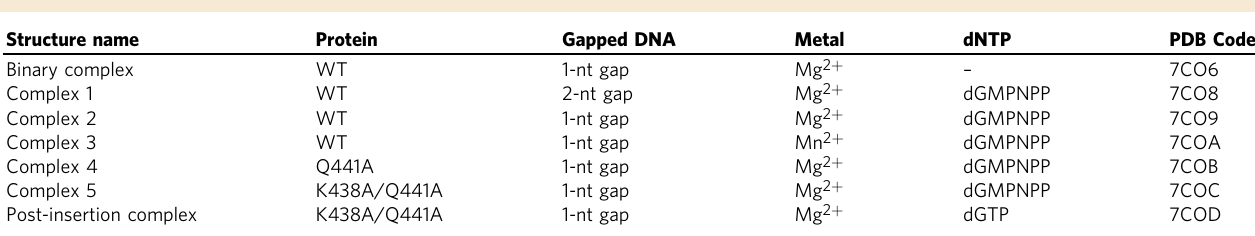
Table 2 Summary of